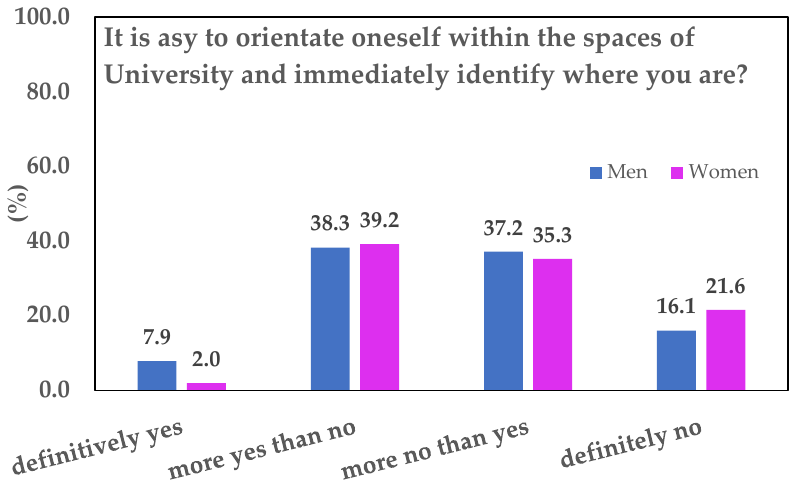
Figure 7. Readability of spaces on Campus of Fisciano.